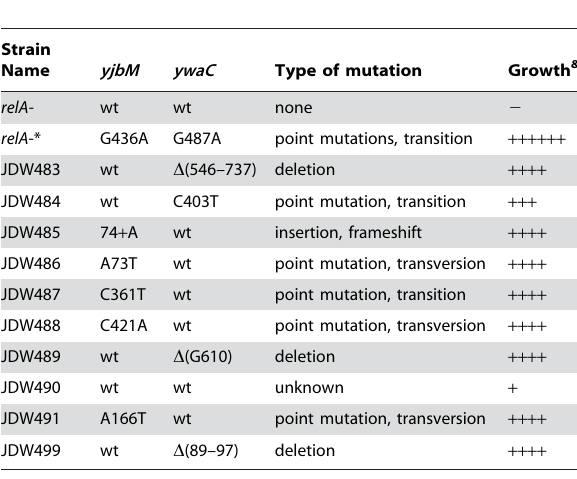
Table 4. Spontaneous suppressor mutations in JH642 with a relA deletion.